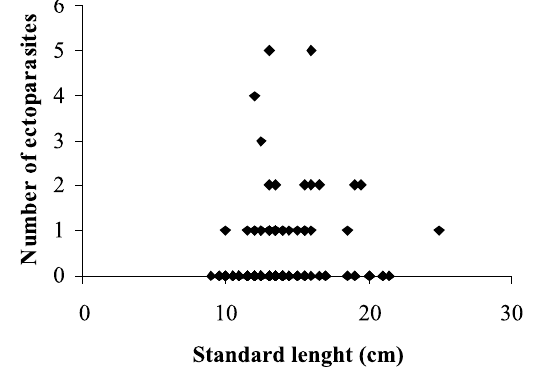
Fig. 3. Correlation between the standard length of Pygocentrus nattereri and the number of branchiurans (intensity of infestation) in lakes and an oxbow lake at the rio Araguaia, State of Goiás, Amazon basin. (rs= 0.2397, p=